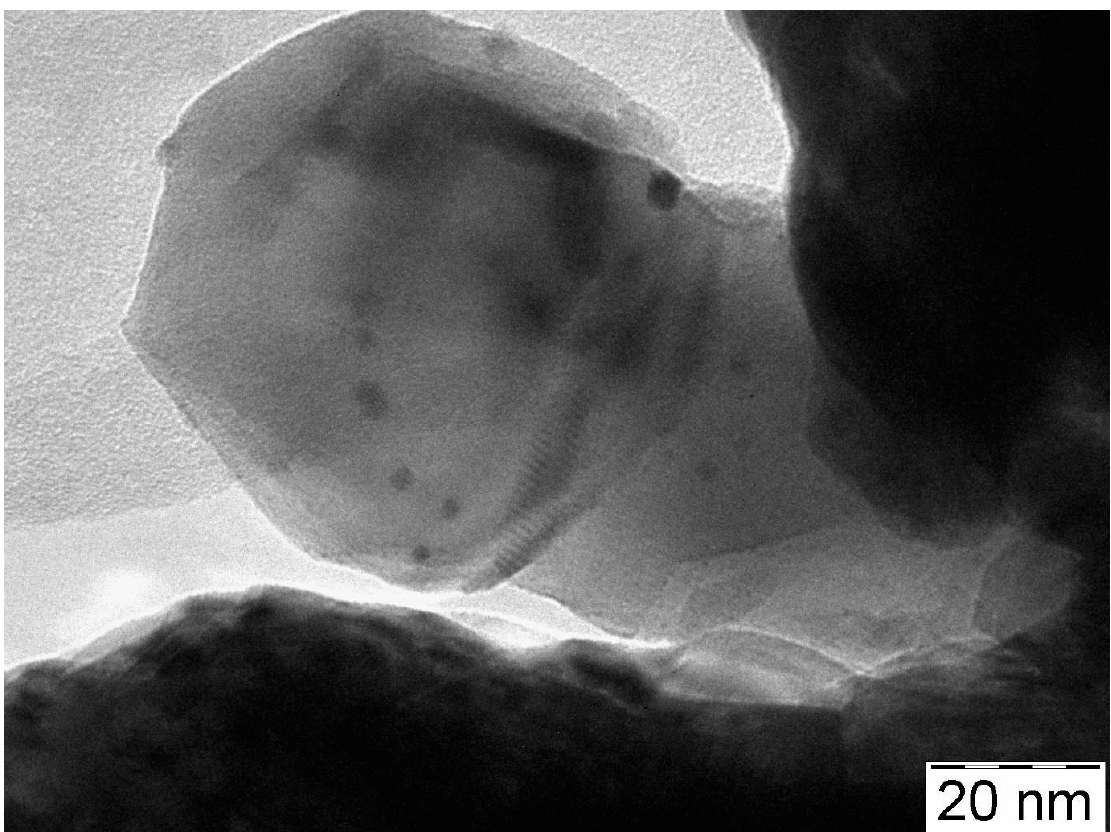
Figure 7. TEM images of the Rh/CeO 2 catalyst reduced at 300 ◦ C under hydrogen flow and scraped from the foam